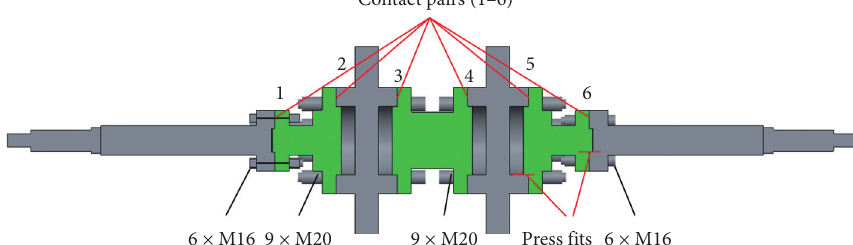
Figure 1: Experimental tie-bolt rotor with distributed pretension by tie-bolts.